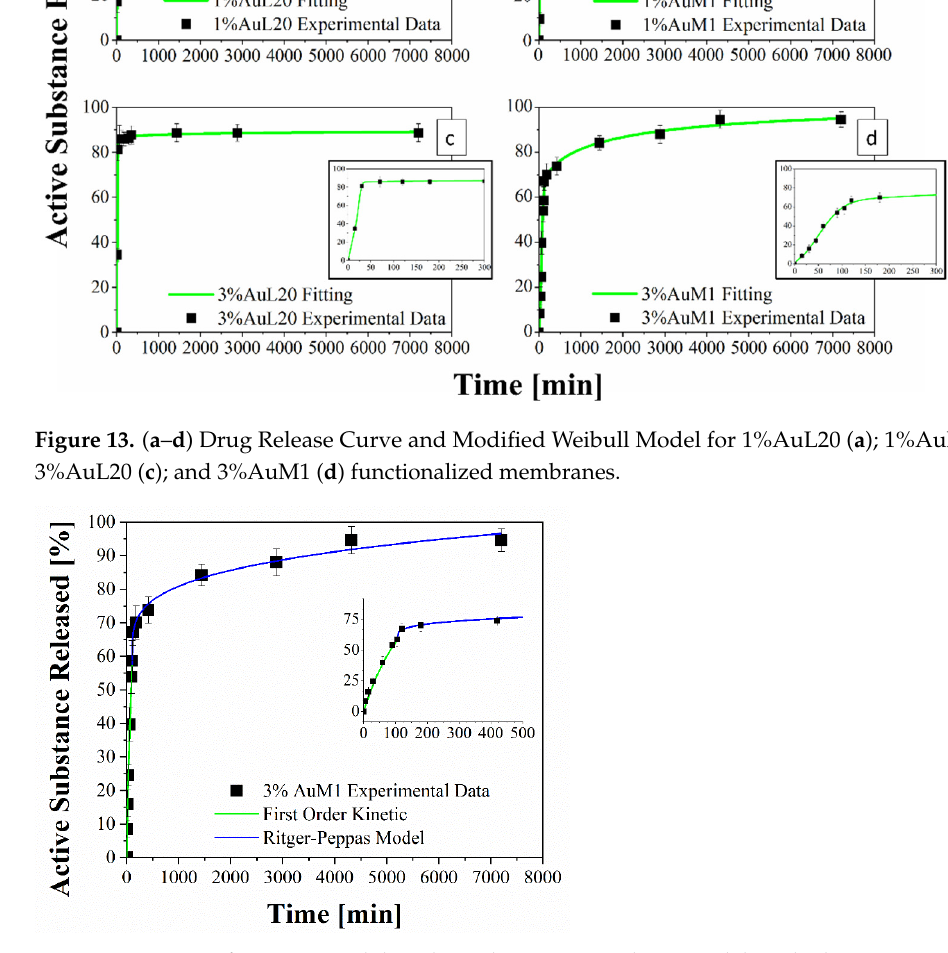
Figure 14. Fitting of experimental data through two-stage release model applied to 3%AuM1. Table 7. Fitting parameters of drug release.